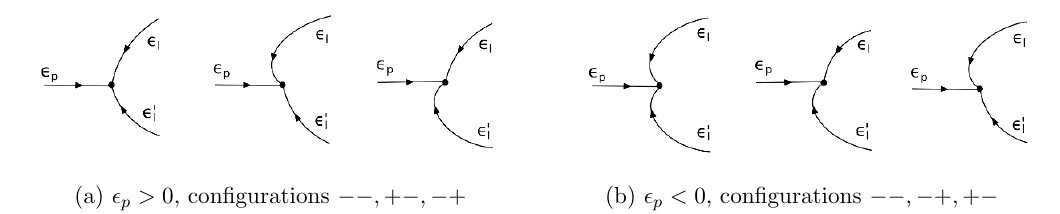
Figure 5 . Possible behaviour of geodesics in the vicinity of the vertex. Arrows show the orientation of geodesics, chosen in the